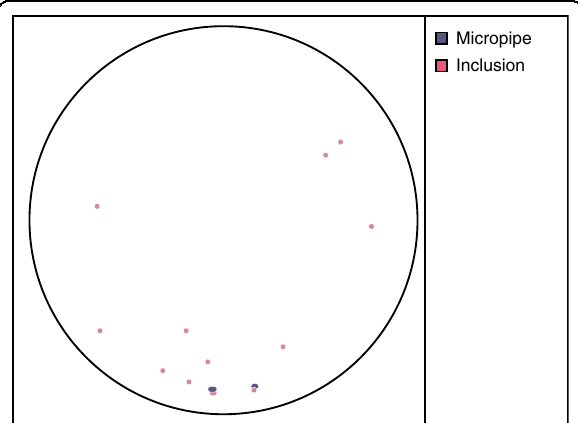
Fig. 8 The micropipe distribution of 6-inch HPSI SiC substrate (only two micropipes)